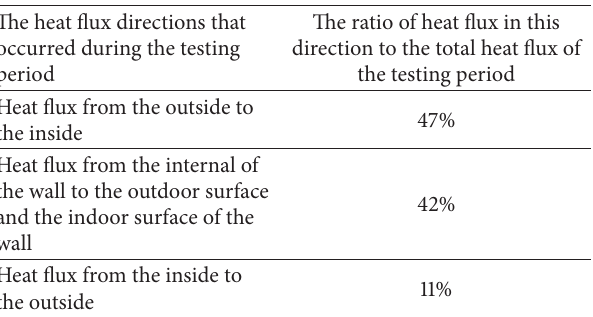
Table 2: The ratio of heat flux in each direction to the total heat flux in the state that air-conditioner runs in the